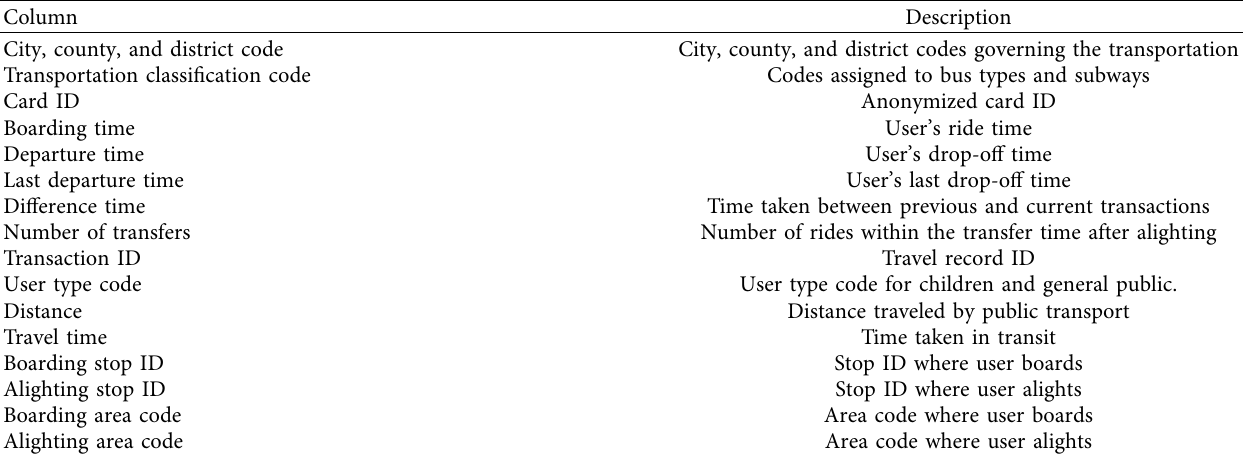
Table 1: Summary of selected columns in smart card